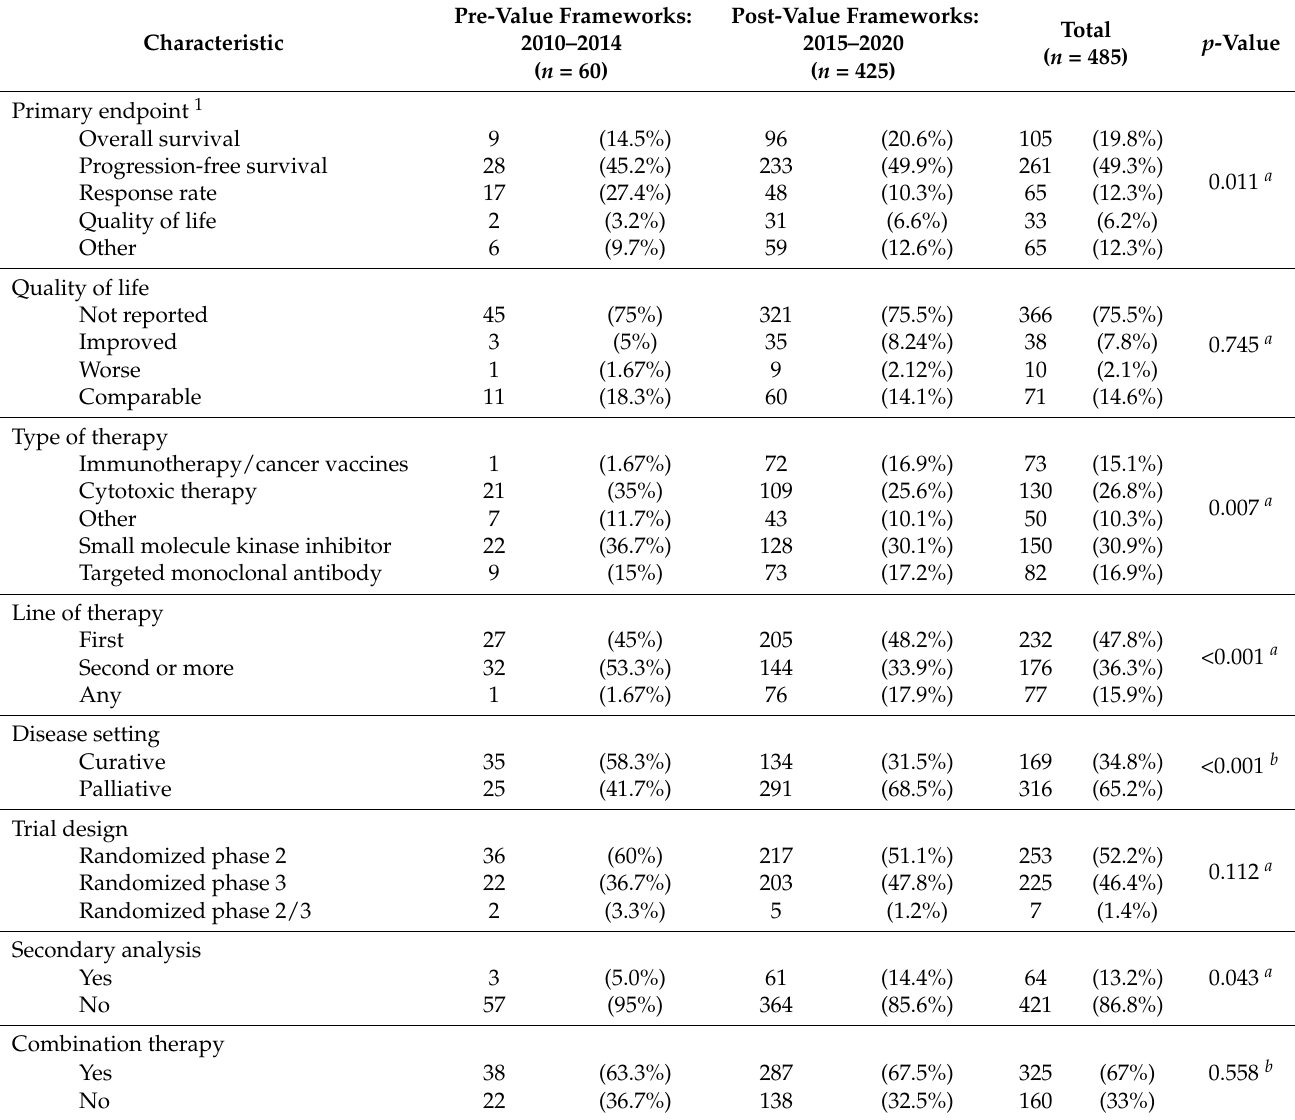
Table 1. Analysis of study characteristics pre- and post-publication of value